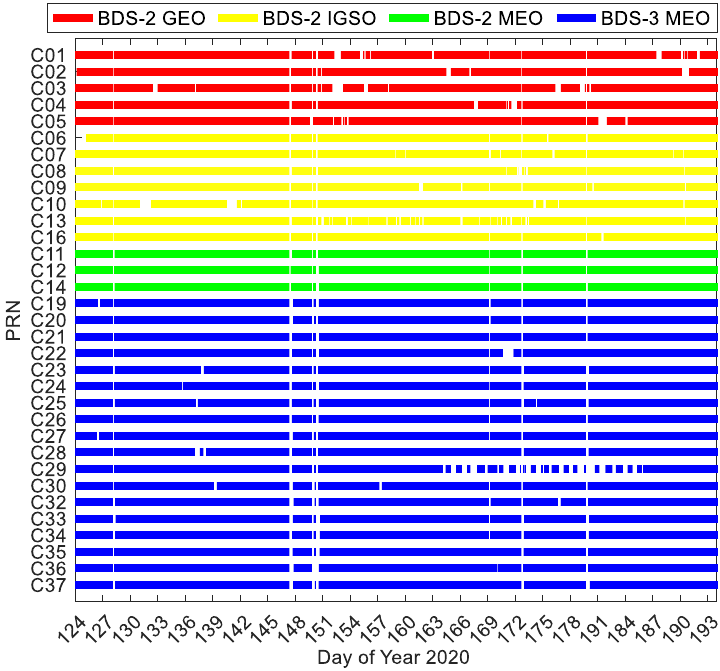
Figure 6. Epoch-wise data availability of BDS-3/BDS-2 real-time precise satellite products.